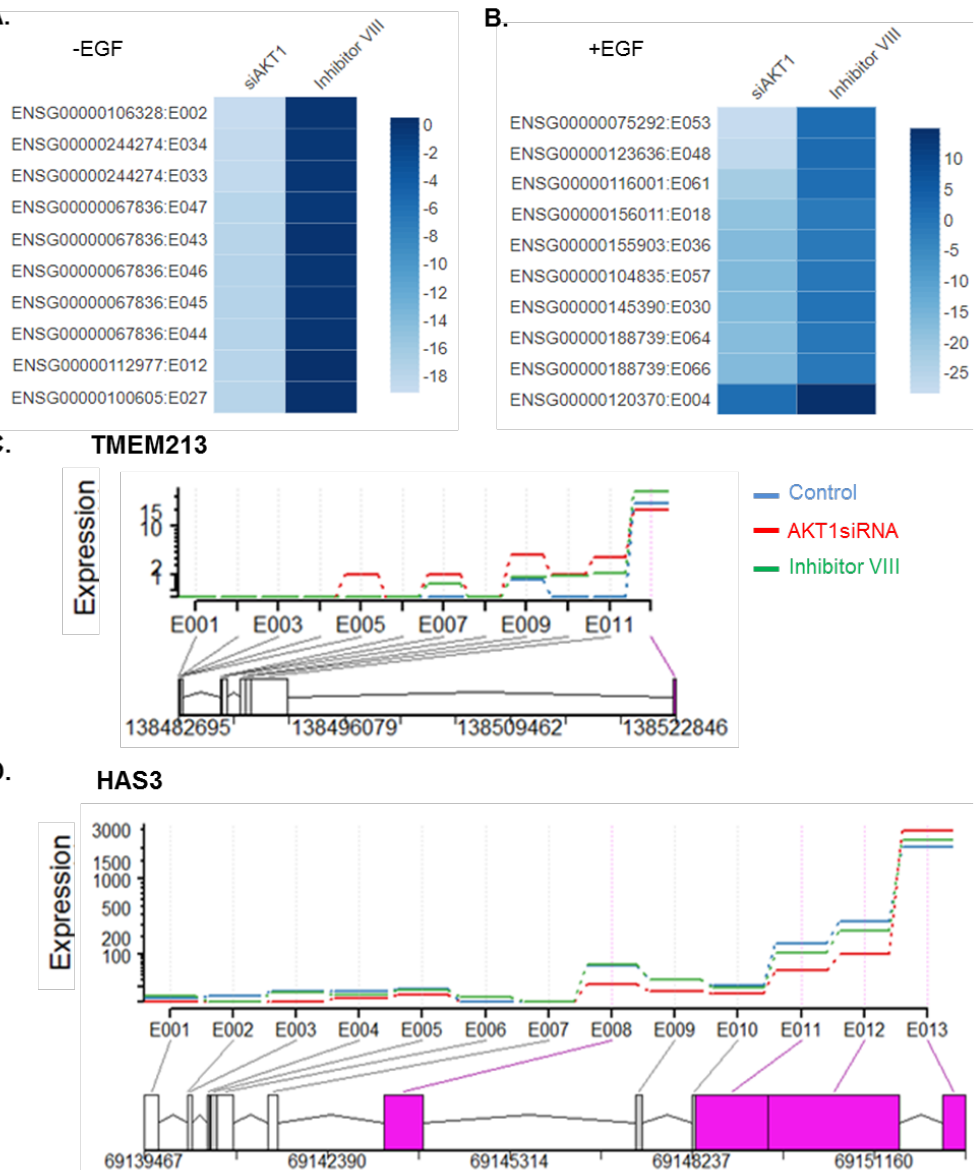
Figure 7. Highly dispersed splicing events observed between AKT1 silenced cells upon EGF stim- ulation. ( A , B ) Top 10 differential spliced variants in AKT1 silenced samples with or without EGF stimulation; ( C ) exon-based splicing of TMEM213 showing differential splicing of exon 12 under indicated experimental conditions; and ( D ) exon-based splicing pattern of HAS3 showing differential splicing of exon 8, 11, 12, and 13. Spliced exons are denoted in pink.